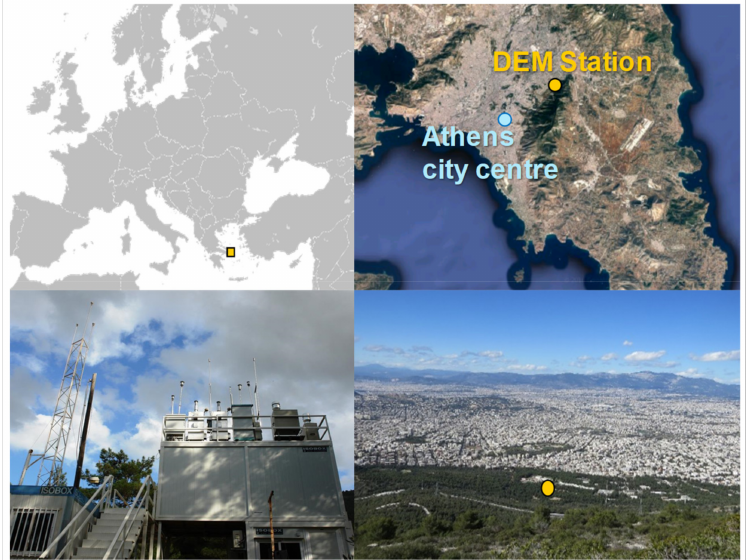
Figure 1. The Demokritos (DEM) urban background station in Ag. Paraskevi, Athens, Greece (37.995 ◦ N 23.816 ◦ E, at 270 m above sea level